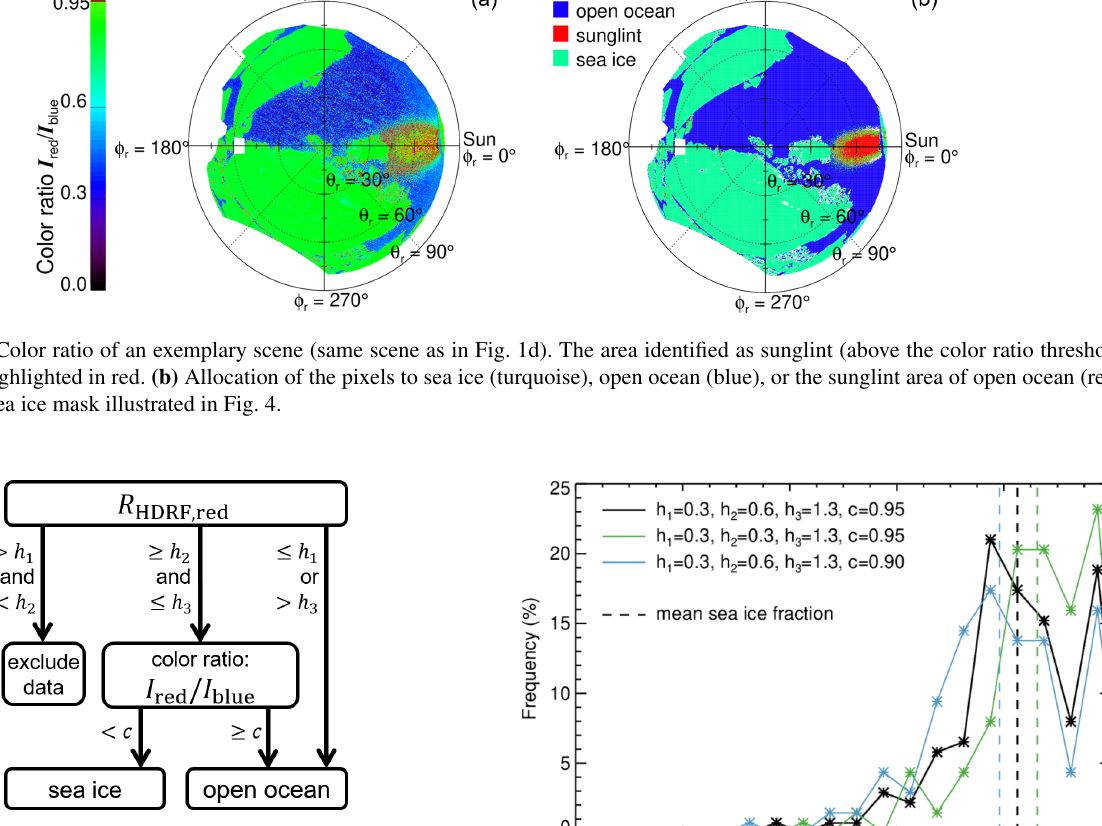
Figure 4. Decision tree separating pixels covered by sea ice and open ocean, defining the sea ice mask. The applied thresholds h 1 = 0 . 3, h 2 = 0 . 6, and h 3 = 1 . 3 are based on the HDRF retrieved for the red camera channel R HDRF,red . The threshold c = 0 . 95 is based on the ratio of the radiances measured in the red I red and the blue I blue channel.